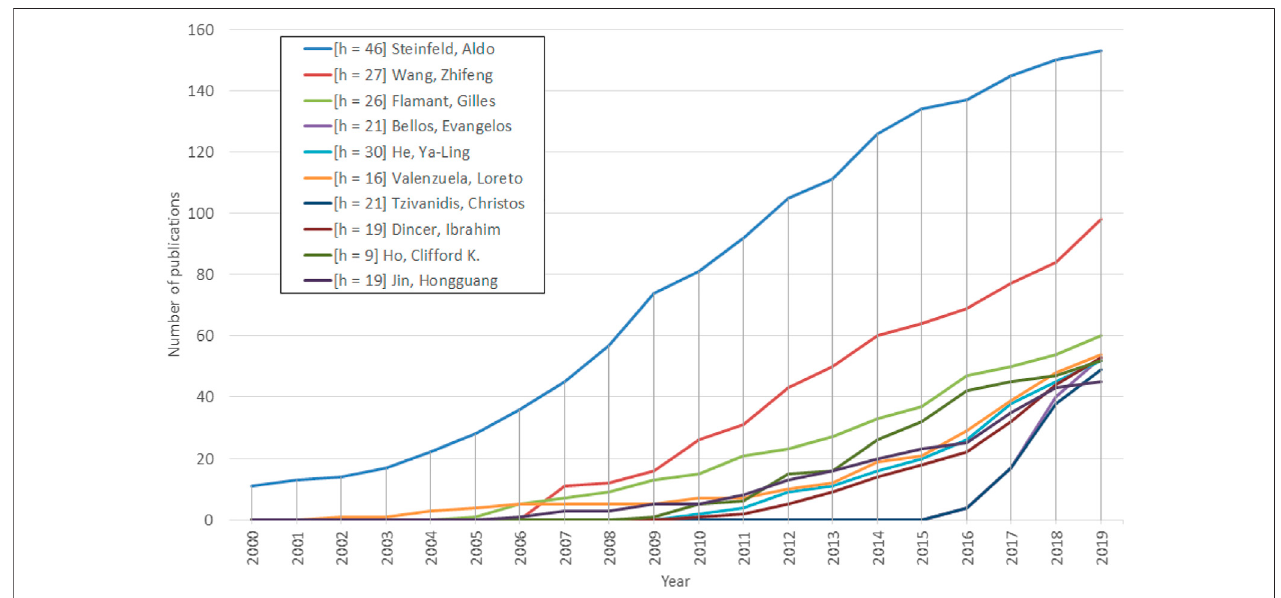
FIGURE 6 | Cumulative author evolution by publications for the last 2